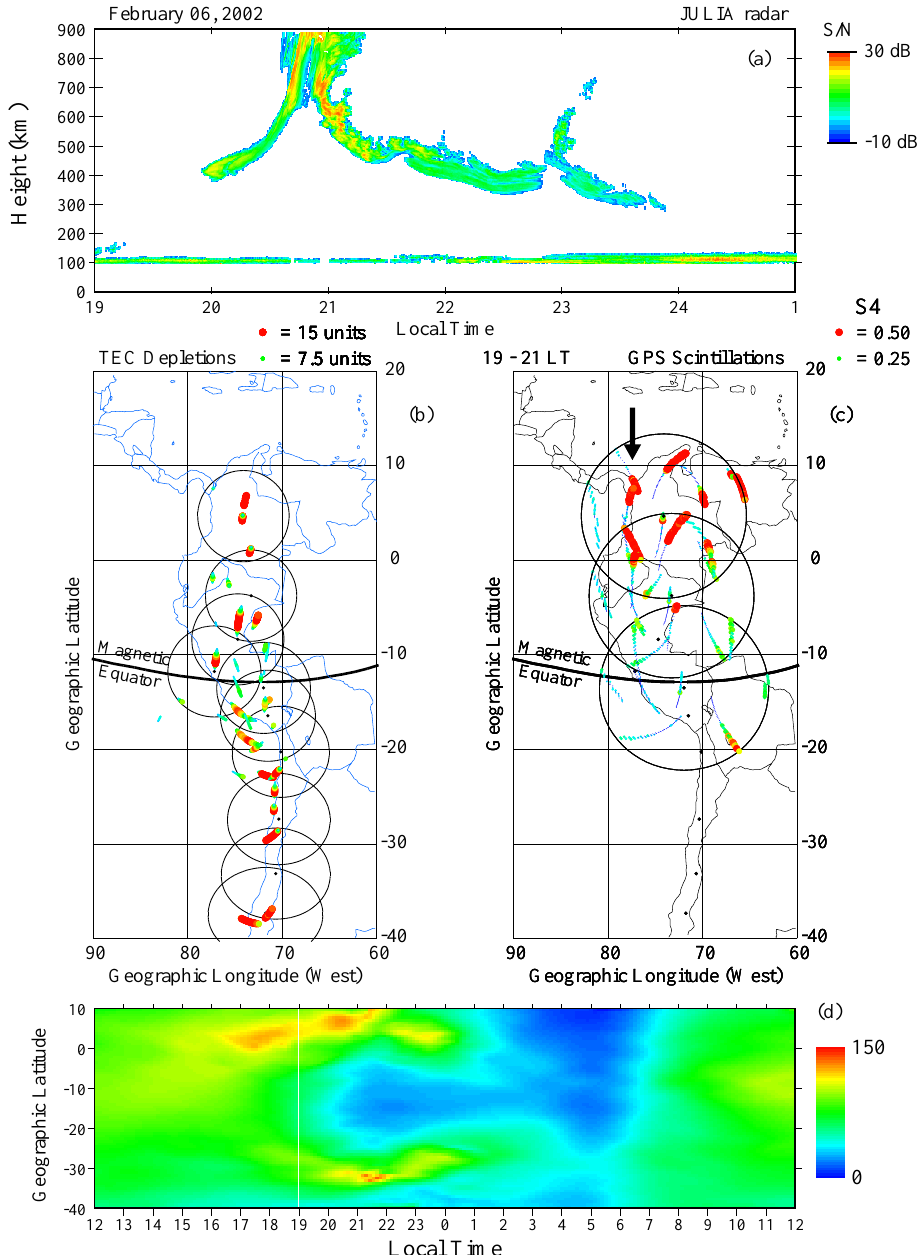
Fig. 6. Same as Fig. 4, but corresponding to 6 February 2002. The radar map shows two plumes. The first occurs between 20:40 and 21:10 LT and extends beyond 900km. The TEC depletions and GPS scintillations detected at several sites extend up to 23 degrees magnetic latitude and indicate that the plasma bubbles extend up to 1400km